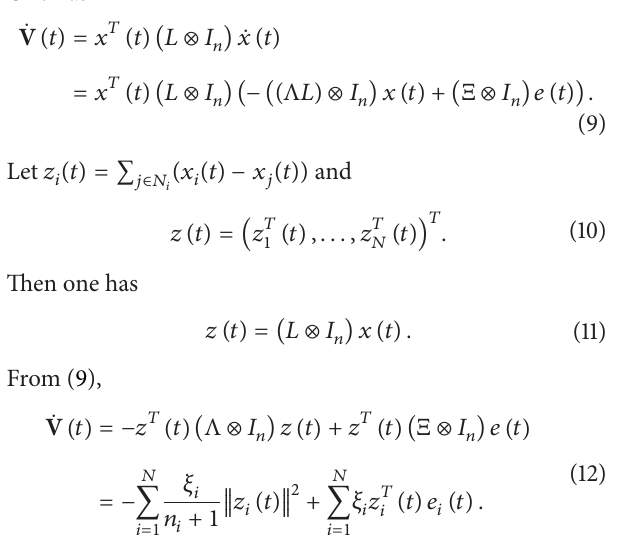
Figure 3: Control inputs of